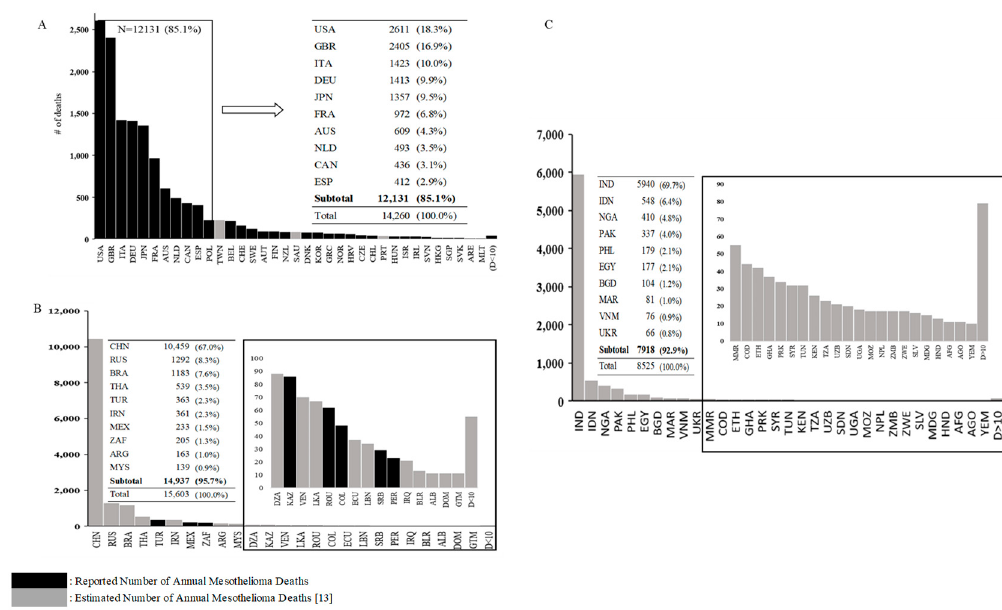
Figure 2. Number of Reported/Estimated Annual Mesothelioma Deaths by Countries According to National Income Category. A: High income countries (N = 80), B: Upper middle-income countries (N = 60); C: Lower middle income and low-income countries combined (N = 78). See Table 2 and text for